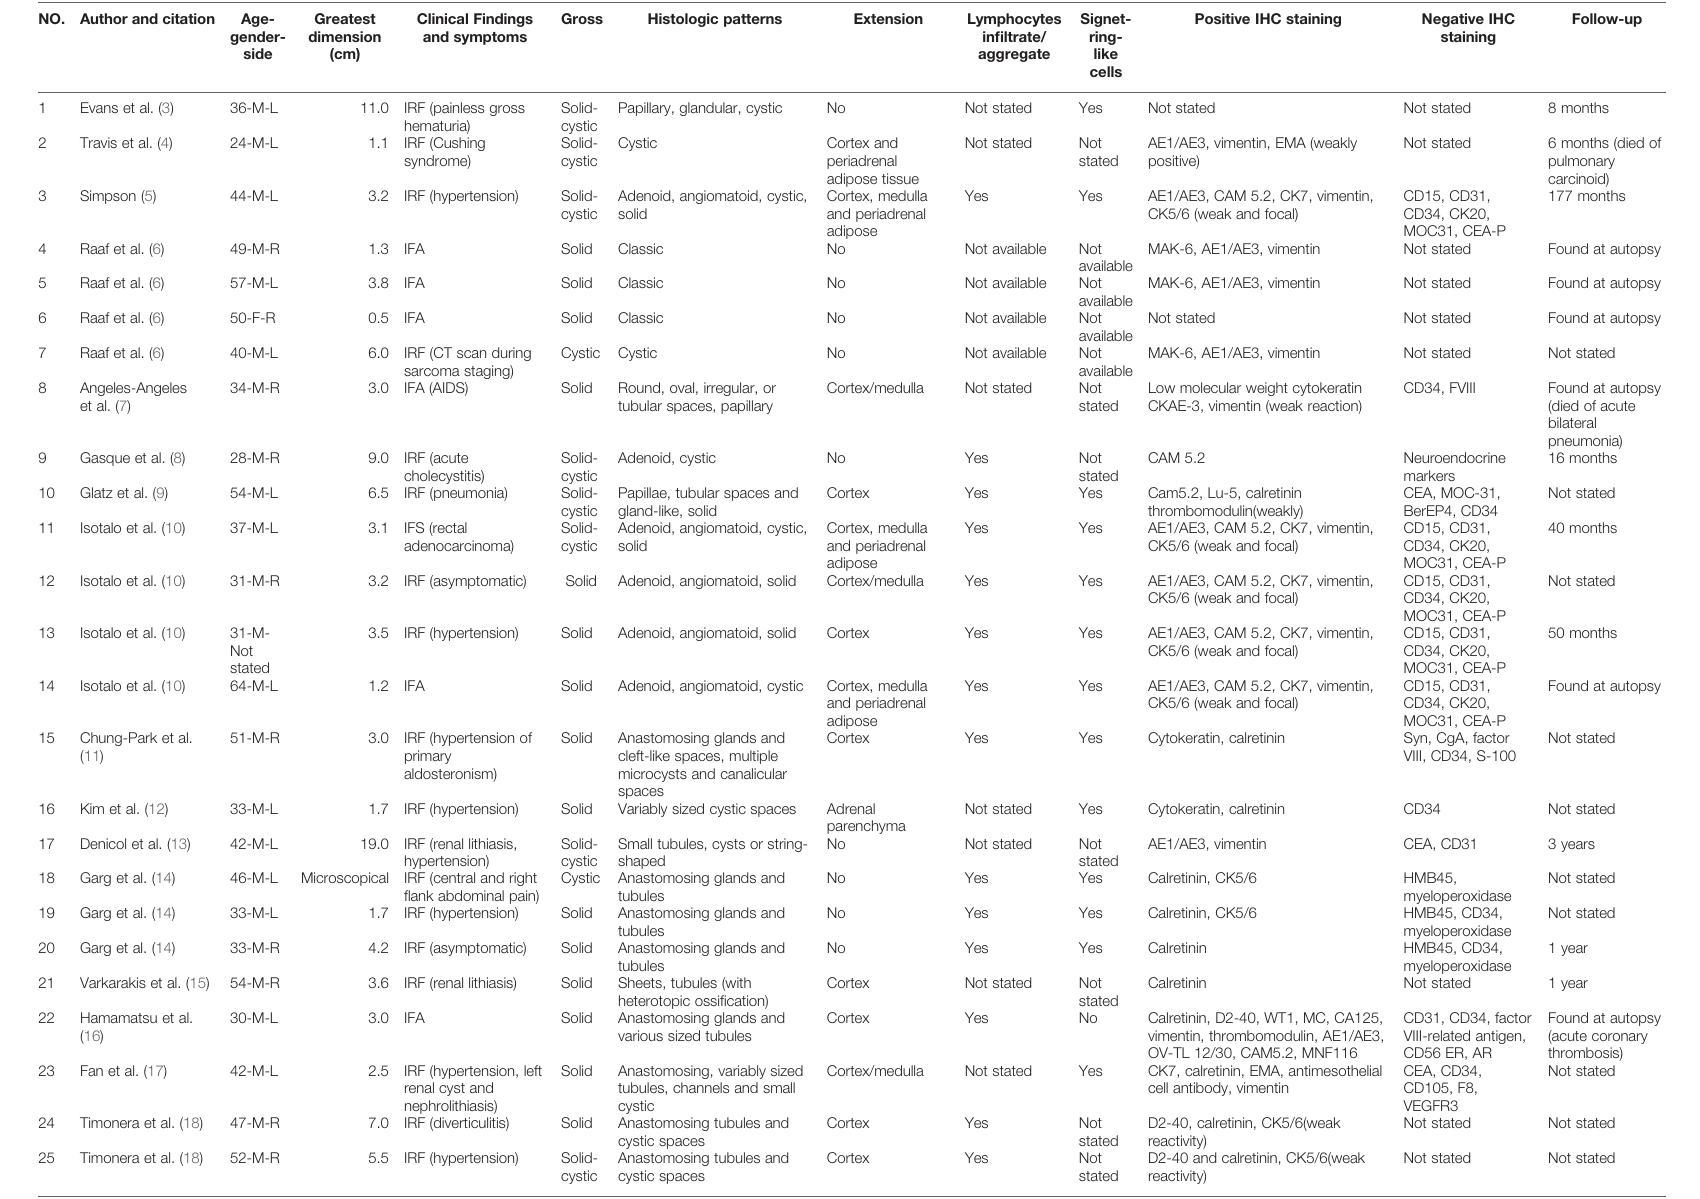
TABLE 2 | Clinicopathological features of adenomatoid tumors of the adrenal